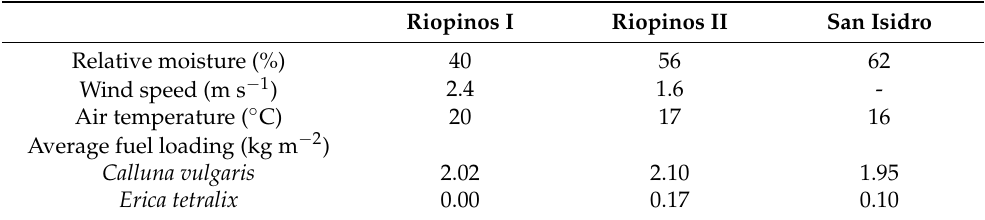
Table 1. Climatic data and average fuel loading at the time of ignition in each of the three selected heathlands in the Cantabrian Mountain Range in 2005